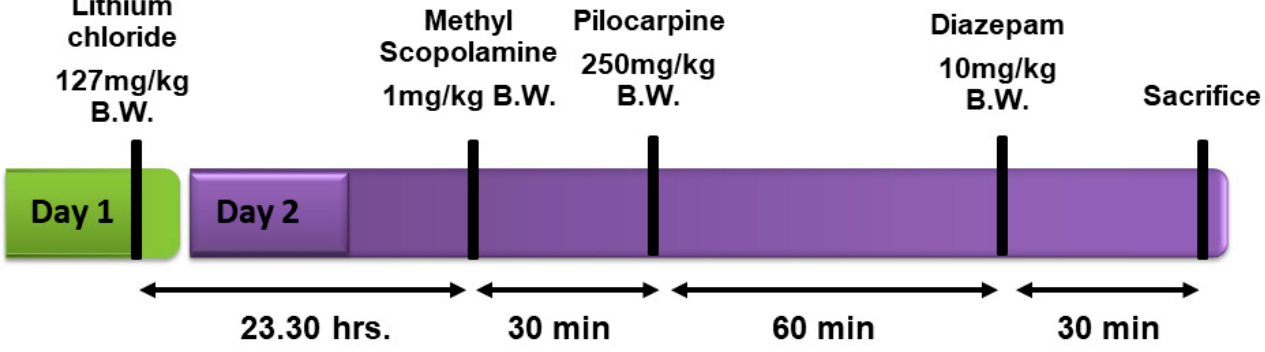
Figure 1. Timescale for creation of lithium–pilocarpine model of status epilepticus. (B.W.: body weight).